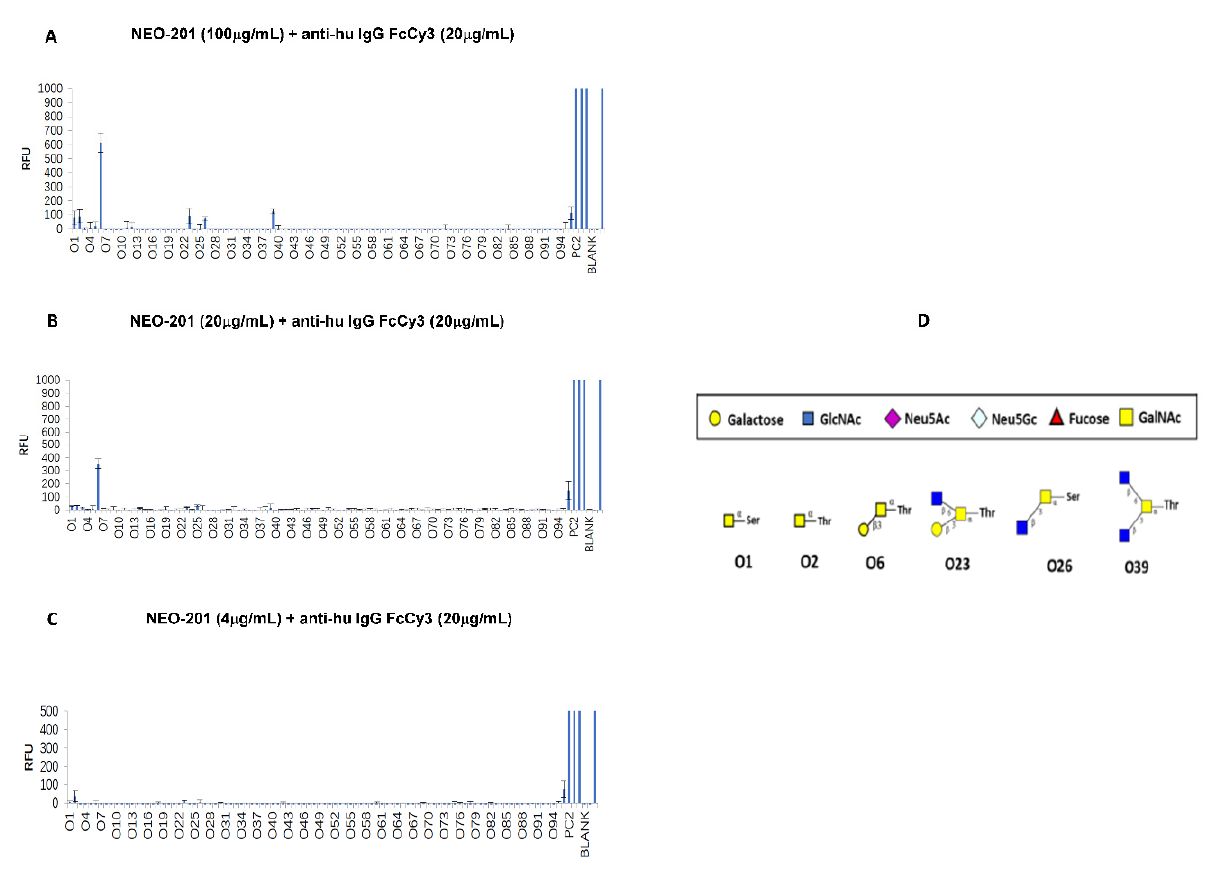
Figure 2. Analysis of NEO-201 binding to the O-glycan array. ( A – C ): NEO-201 was used at concen- trations of 100, 20 and 4 μ g/mL, and anti-human IgG FcCy3 was used at 20 μ g/mL. The array was read using an Innopsys InnoScan 710 Microarray Scanner with a high-power laser at 5PMT. Software was used to detect each spot on the array and to calculate the relative fluorescence units (RFU) intensity for each spot. Background RFU was subtracted from each spot’s RFU value. The RFU scale is presented in vertical axes. ( D ): O-glycans recognized by